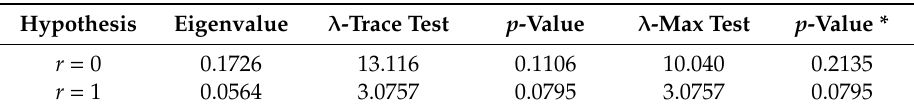
Table 5. Johansen’s test for cointegrating vectors between beech roundwood prices in Slovenia and